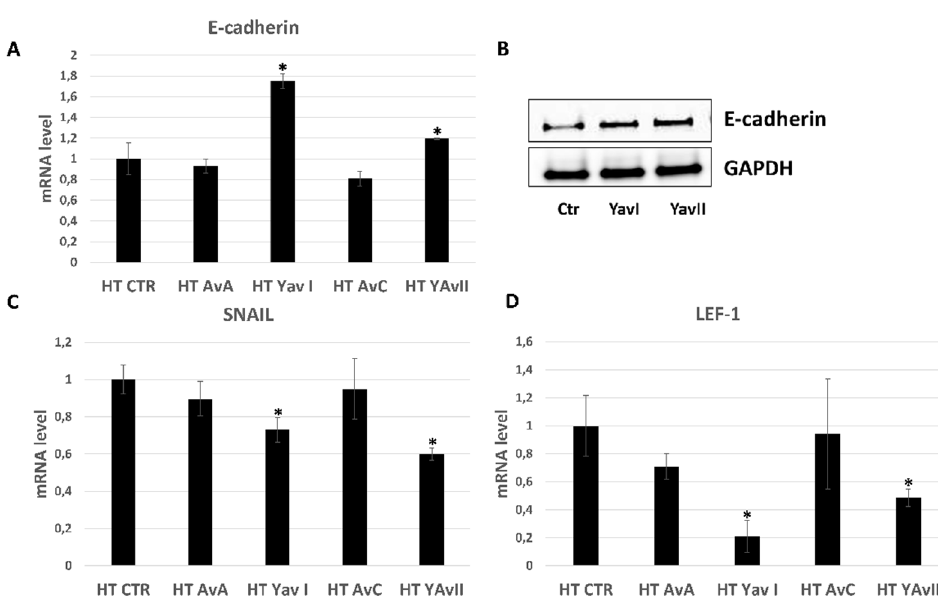
Figure 7. Yeast avenanthramides regulate E-cadherin expression. ( A ) Quantitative PCR for E-cadherin mRNA expression in cells exposed to YAvnI and YAvnII (200 µ M, 48 h). E-cadherin mRNA expression is reported as fold increase compared with basal levels (* p < 0.05); ( B ) Representative images of western blot analysis of HT29 cells exposed to YAvnI and YAvnII (200 µ M, 48 h); ( C , D ) Quantitative PCR for Snail1 and LEF-1 expression in cells exposed to YAvnI and YAvnII (200 µ M, 48 h). Data are expressed as fold increase compared with control (* p <